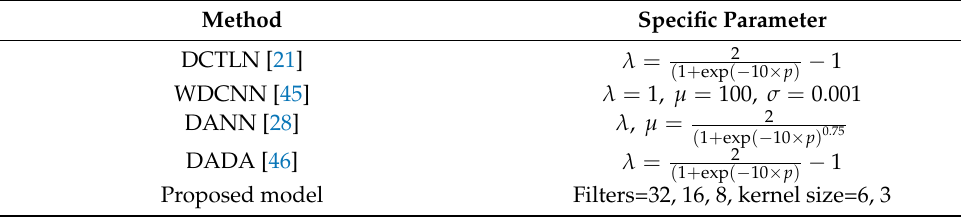
Table 2. Parameter setting in each learning model.